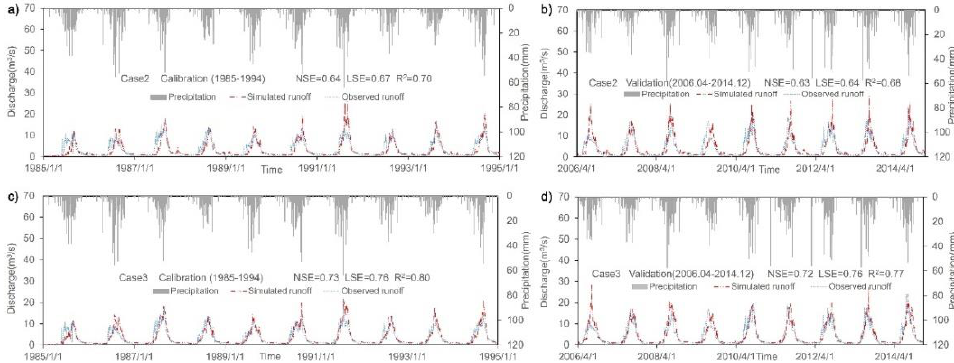
Figure 8. Comparison of daily runoff simulation results from the J2000 model using the traditional TLR scheme (Case 2, a , b ) and the new TLR scheme (Case 3, c , d ) for the periods of calibration ( a , c ) and validation ( b , d ), when the precipitation gradients were derived from station observations.